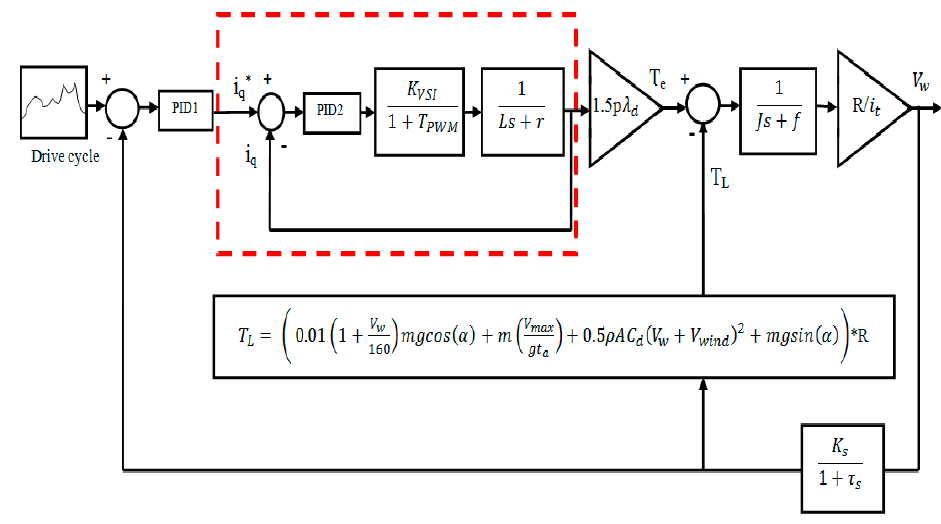
Figure 4. Electric vehicle field oriented controlled scheme.